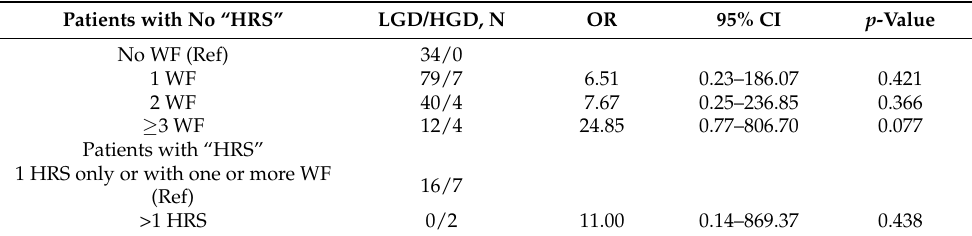
Table 4. Prediction of HGD based on number of “WF” and/or instances of “HRS” in patients with